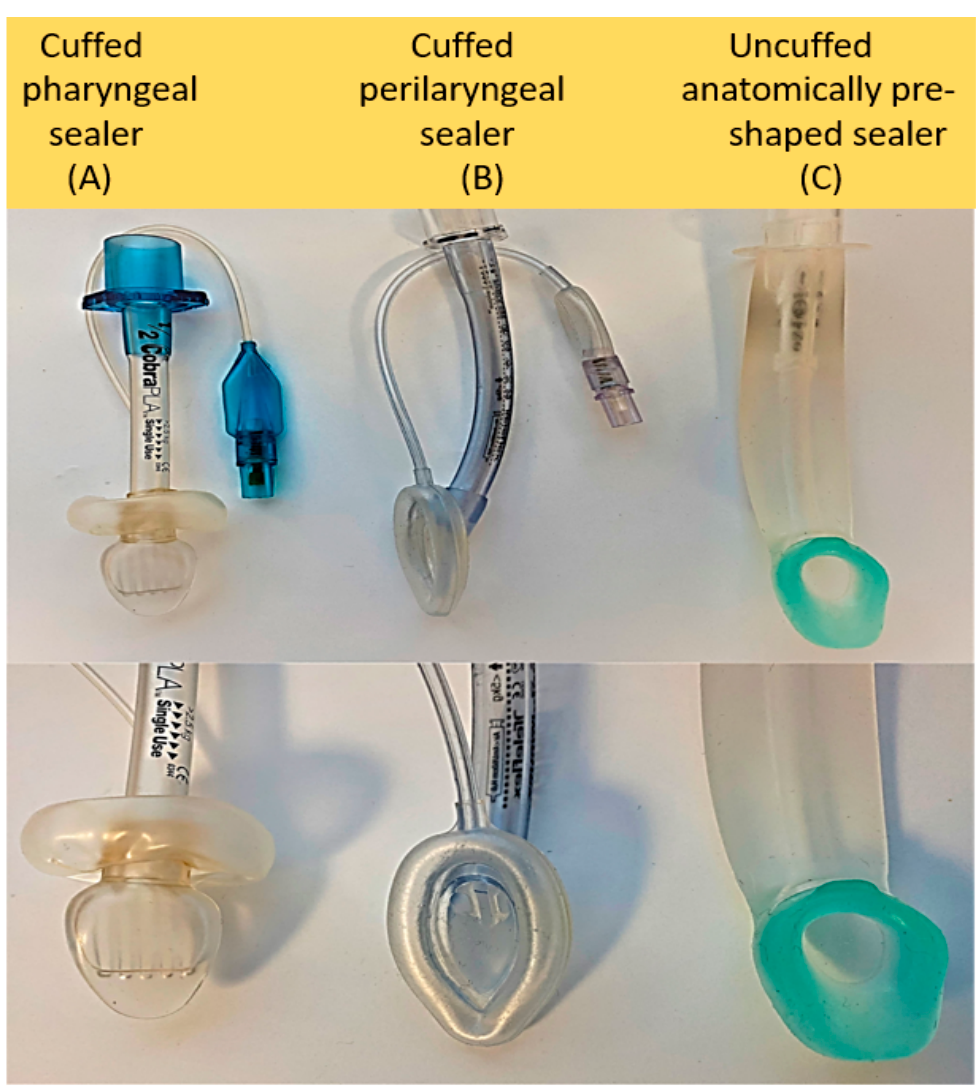
Figure 1. Neonatal-sized samples of the three archetypal devices, namely ( A ) Cobra Perilaryngeal Airway, ( B ) Laryngeal Mask Airway Unique, and ( C ) i-gel . Airway, ( B ) Laryngeal Mask Airway Unique, and ( C )